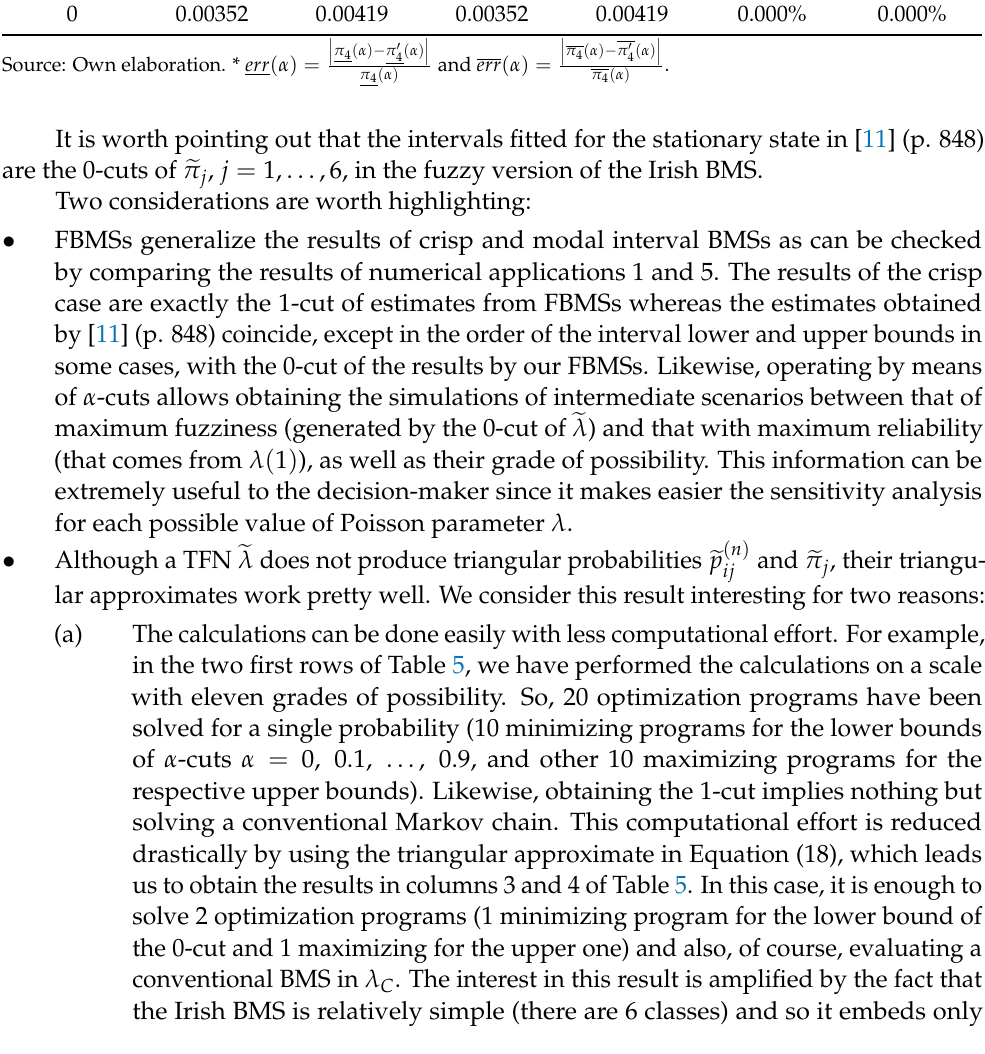
Table 5. α -cuts of (cid:101) π 4 , it’s triangular approximate, (cid:101) π (cid:48)